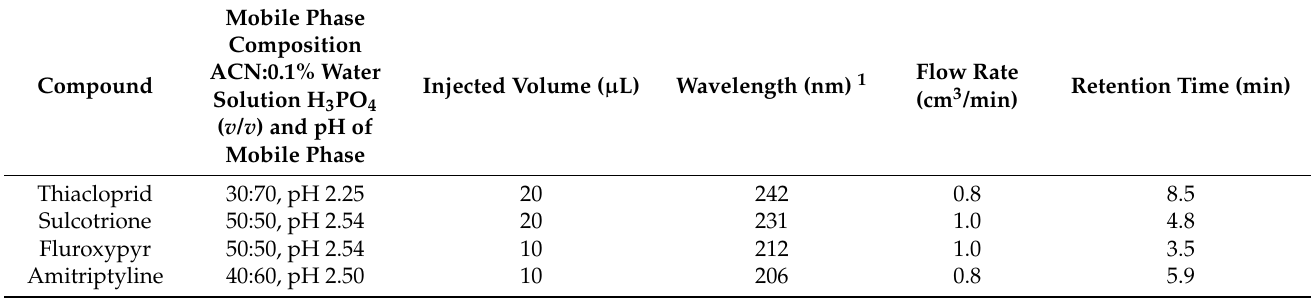
Table 3. The experimental conditions for the isocratic chromatographic analysis of the studied